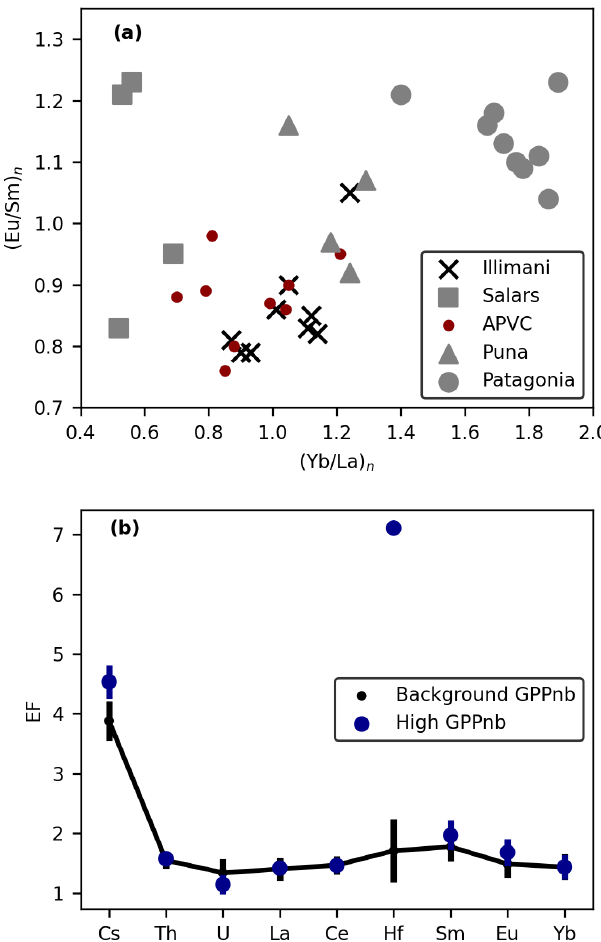
Figure 5. Geochemical signature of the Nevado Illimani firn sam- ples. (a) Relationship between the REE (normalized considering the UCC composition; Rudnick and Gao, 2003) from the Nevado Illi- mani firn core (this work) and sediments and soils from potential dust sources (corresponding to < 63µm grain size for top soils). Data from northern Puna and Uyuni and Coipasa salars are from Gaiero et al. (2013). Data from Patagonia are from Gaiero et al. (2004). Data for the APVC refer to geological samples from Lind- say et al. (2001) and Ort et al. (1996). (b) Enrichment factors (EFs) for different elements and standard deviations. Samples with a high GPPnb (blue circles) show anomalous enrichment for Hf and to a lesser extent for Cs (see